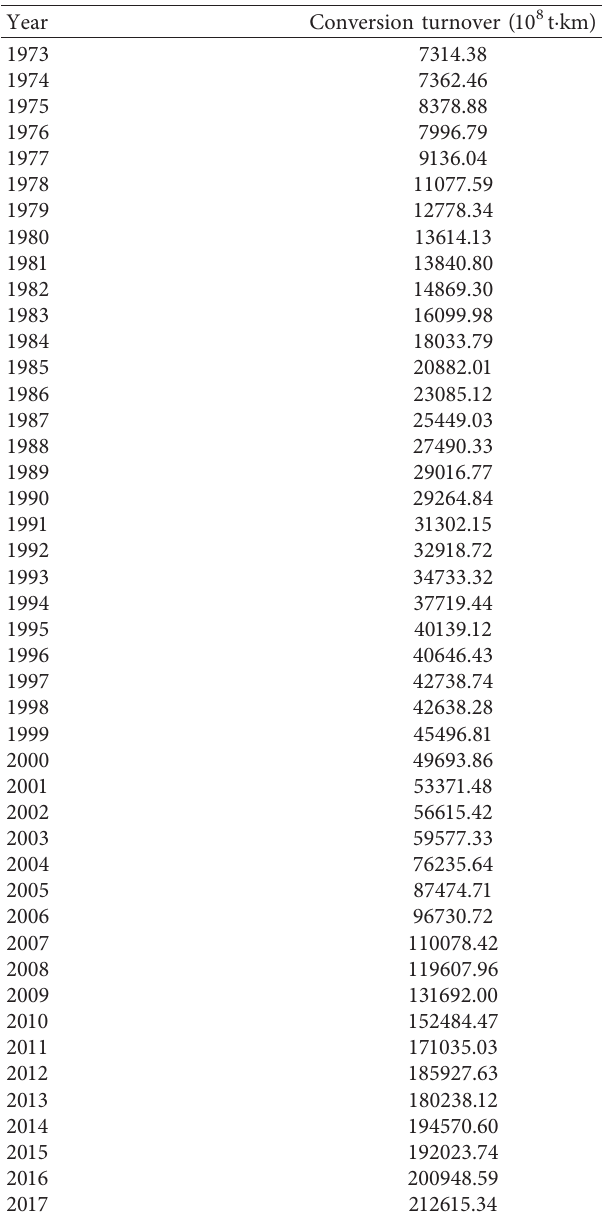
Table 2: Converted turnover of the Chinese transportation in- dustry from 1973 to